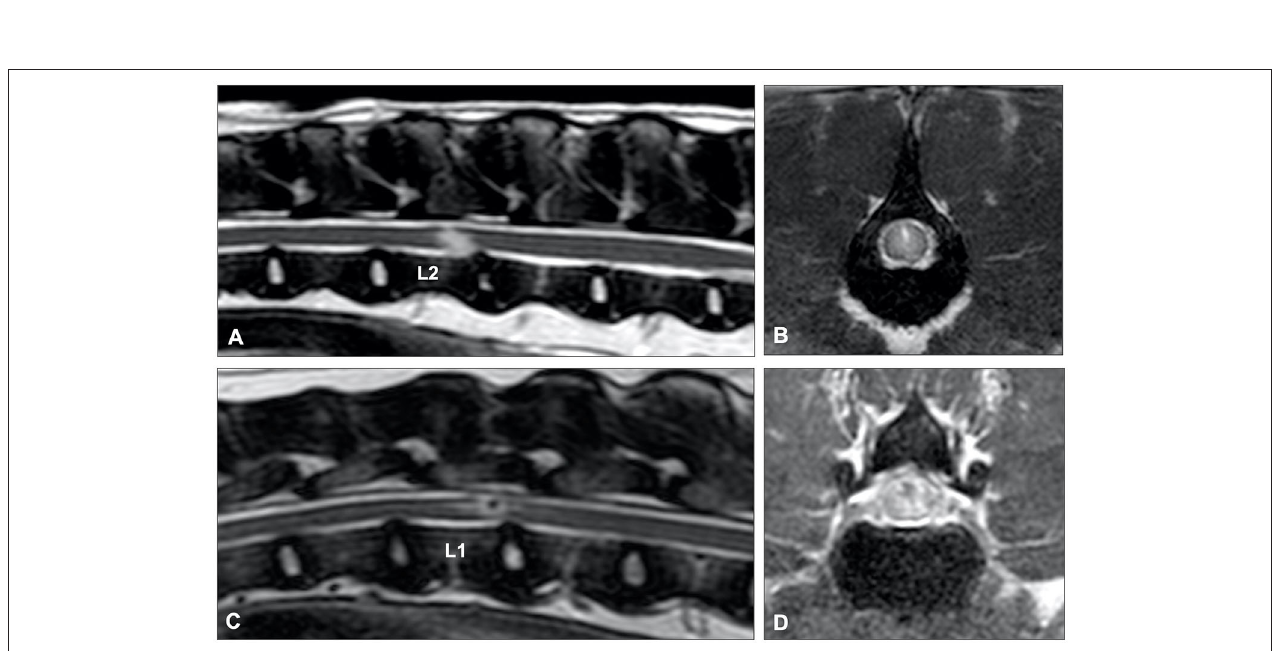
FIGURE 14 | (A) T2-weighted sagittal and (B) BALT GRAD (T2-weighted thin-slice gradient echo) transverse MR images of an 8-year old Greyhound with an L2-L3 IIVDE. (A) The intervertebral disc has a decreased volume of homogenously hyperintense nucleus pulposus. A ventrocaudal to dorsocranial intramedullary linear hyperintensity, starting from the L2-L3 intervertebral disc can be seen. (B) Hyperintense linear tract can be seen through the spinal cord. (C) T2-weighted sagittal and (D) BALT GRAD transverse MR images of a 6-year old Beagle with an L1-L2 IIVDE. The intramedullary lesion has a hypointense center, suggestive for intraparenchymal